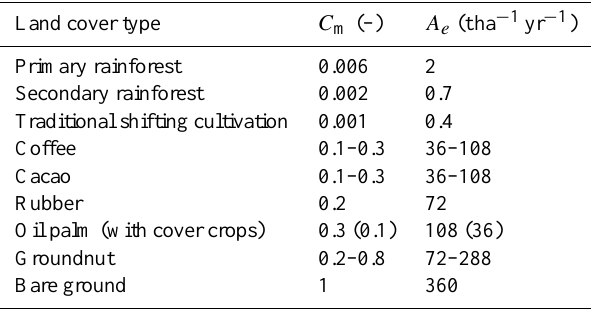
Table 4. Cover and management factor and resulting annual soil loss per unit area for various tropical land cover types (Morgan and Finney, 1982; Besler, 1987; Morgan,